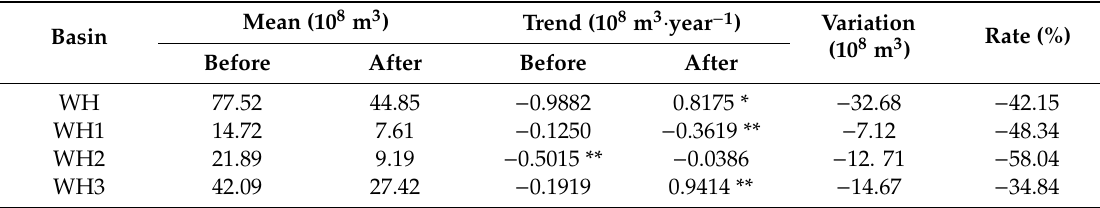
Table 3. Variabilities of runo ff before and after